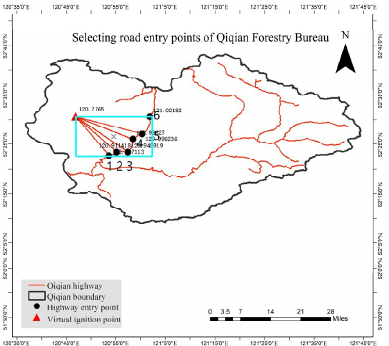
Figure 7. Selection of road entry point diagram. Table 1. Experimental parameters setting.